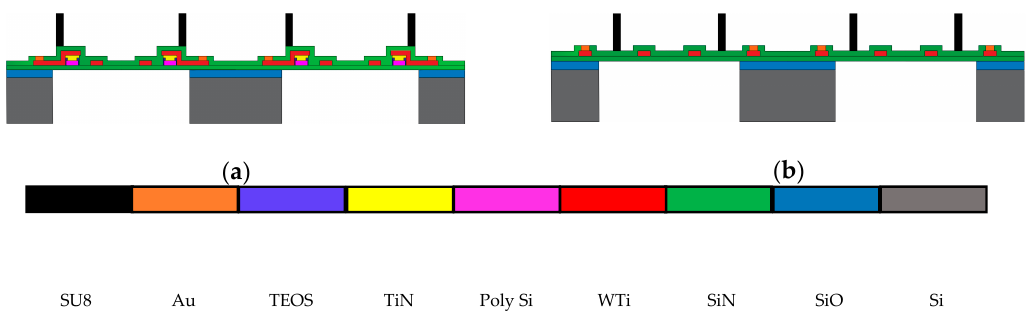
Figure 1. Schematics of the ( a ) thermoelectric sensor and ( b ) thermoresistive sensor.